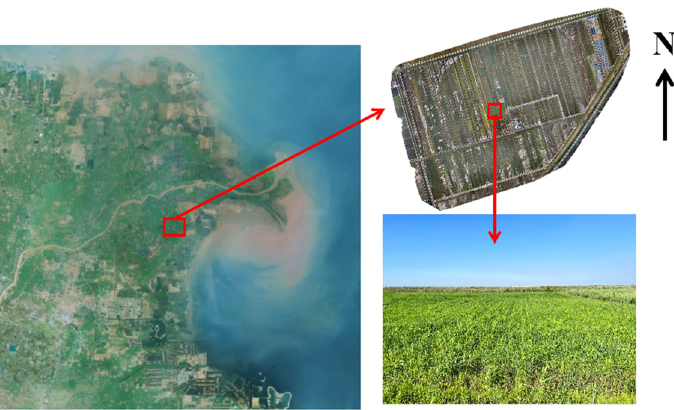
Figure 1. Photographs of the research site and sampling plots. In July 2021, six 20 m × 20 m sampling plots were selected from the dry saline–alkali farmland within 1 km × 1 km in the research site (Figure 1). In each sampling plot, six soil cores were randomly obtained from a depth range of 0–20 cm using a sterilized soil auger and mixed as a representative sample. The sample was screened through a 2 mm soil sieve to remove plant litter and roots and divided into two parts for subsequent analysis.